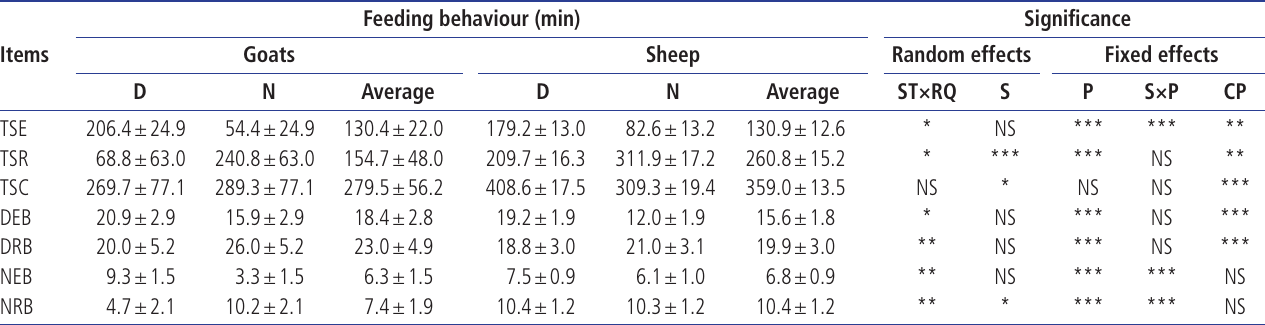
Table 9. Effects of ruminant species, period of the day and their interactions on feeding behaviour (LSM±SEM) of sheep and goats fed varying roughage qualities in 6 different studies Items